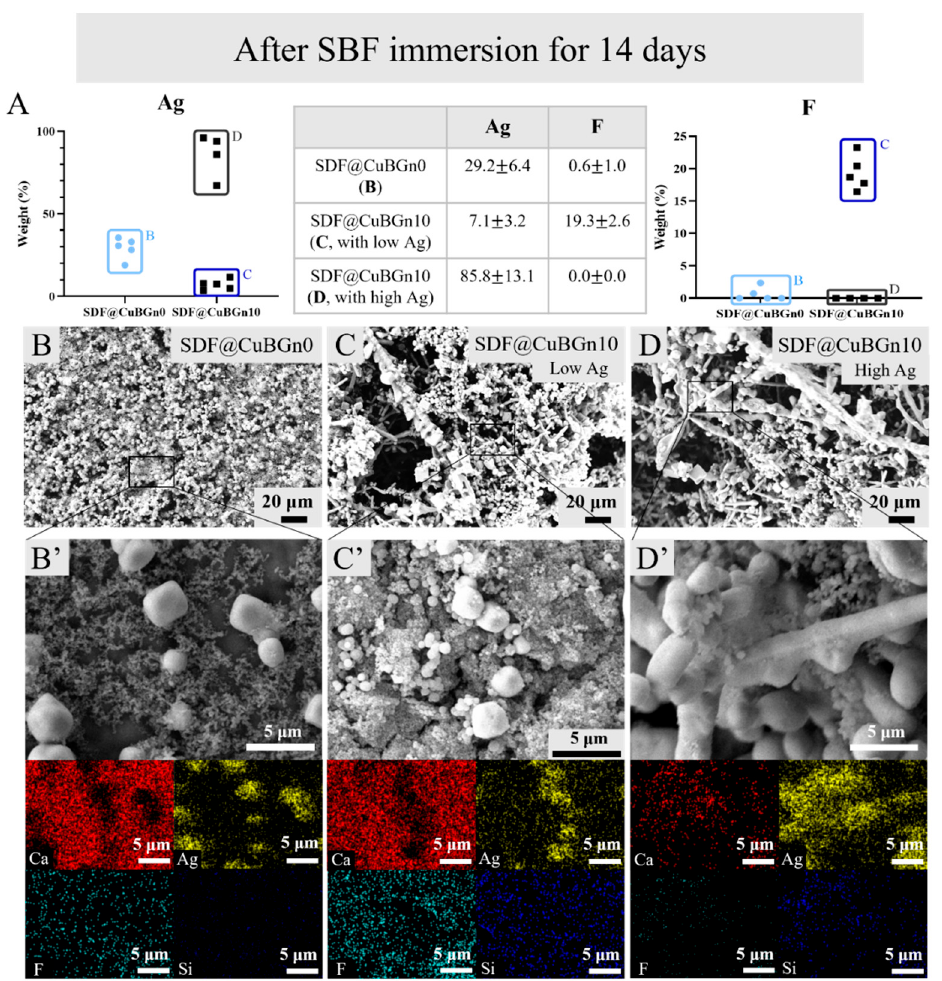
Figure 3. Physicochemical analysis (surface analysis after SBF immersion for 14 days) of SDF@CuBGn ‐ applied HA discs. ( A ) Elemental EDS analysis of Ag and F. ( B ) SDF@CuBGn0 ‐ applied applied HA discs. ( A ) Elemental EDS analysis of Ag and F. ( B ) SDF@CuBGn0-applied HA disc HA disc and ( B’ ) magnified image. ( C , D ) SDF@CuBGn10 ‐ applied HA disc and ( C’ , D’ ) magnified and ( B’ ) magnified image. ( C , D ) SDF@CuBGn10-applied HA disc and ( C’ , D’ ) magnified image. SDF@CuBGn0 ‐ and SDF@CuBGn10 ‐ applied HA discs were immersed in SBF, which is opti ‐